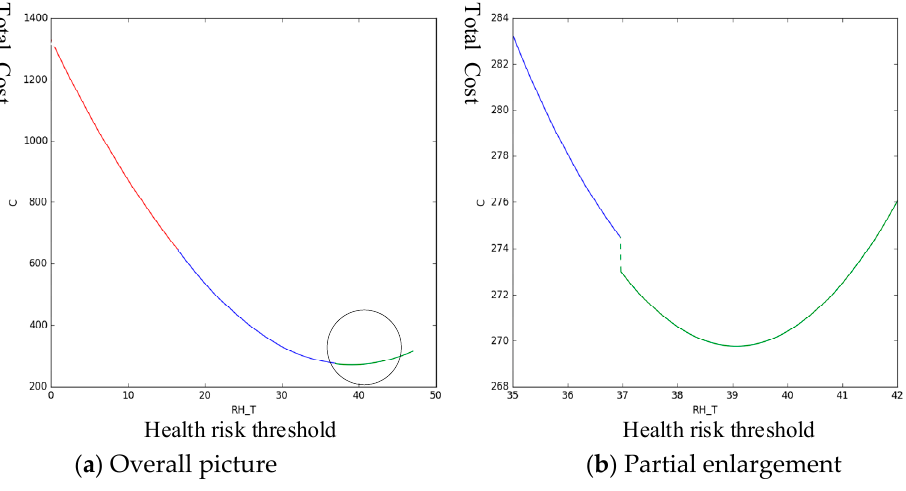
Figure 8. Trend in total costs under different health risk thresholds.